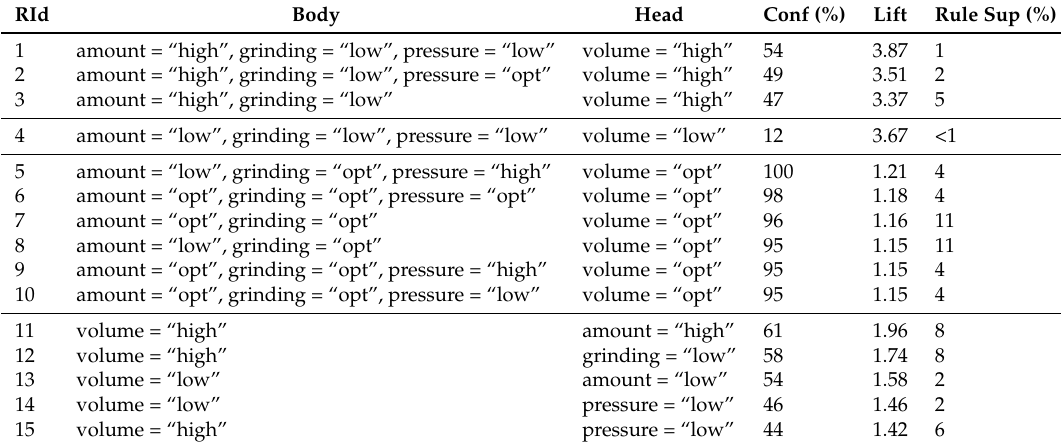
Table 8. Association rules involving the espresso volume correlations.